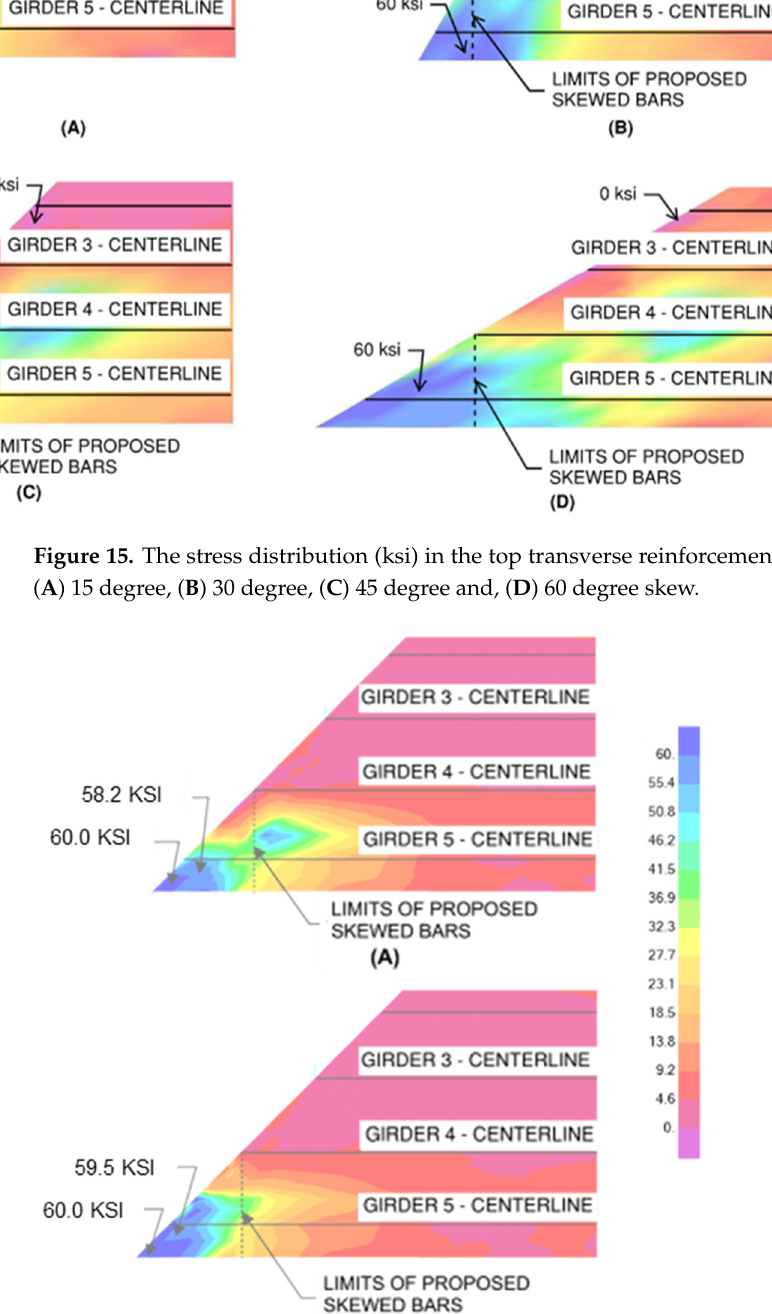
Figure 16. The stress distribution (ksi) in the top transverse reinforcement for Design Case 1, 45 degree model with ( A ) proposed reinforcement pattern and ( B ) unmodified reinforcement at acute corner.